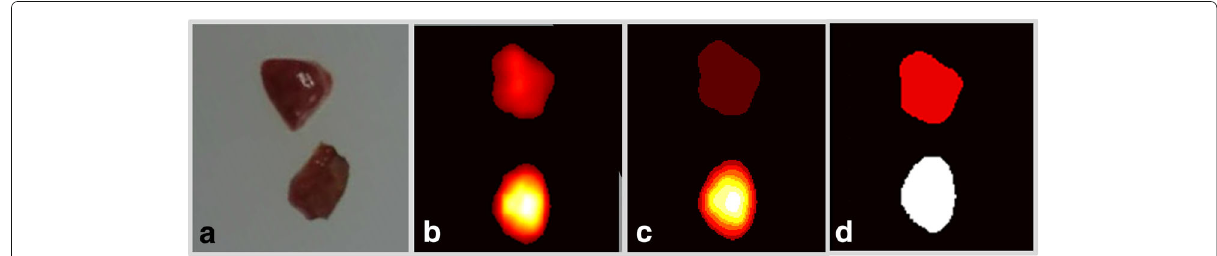
Fig. 7 Liver phantom results. a Imaged regions of the experimental phantom. b Photoacoustic tomography imaging after thresholding of experimental phantom at 700 nm. c Resulting spatio-spectral mean-shift map. d Segmentation map after